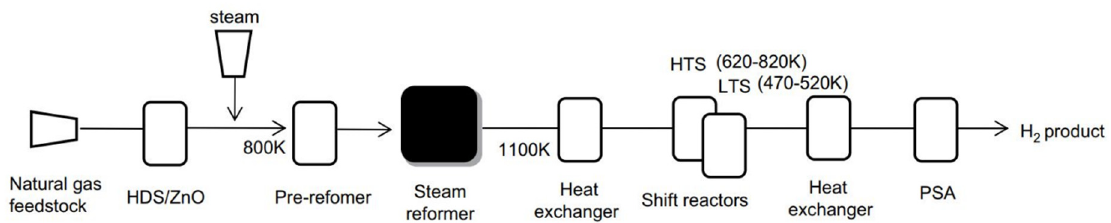
Figure 3. Schematic diagram of the conventional SMR process (Reproduced with permission from [43], Elsevier; 2009).